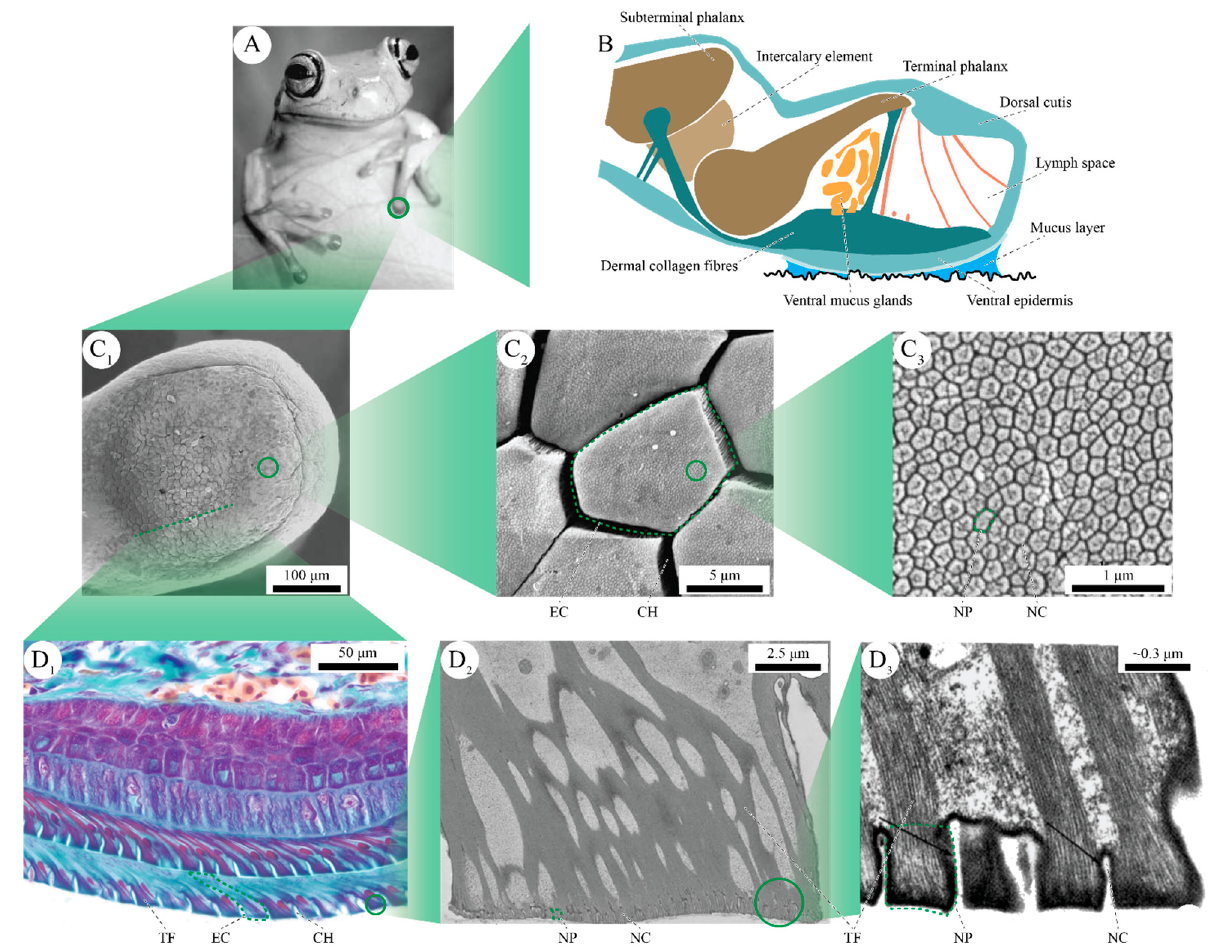
Figure 1. Functional morphology of the adhesive toe pads of healthy hylid tree frogs. ( A ) Litoria caerulea with toes in contact with a substrate. ( B ) Schematic depiction of the functionally relevant structures in the tip of a tree frog digit, lateral view. ( C 1–3 ) Superficial morphology of the ventral pad epidermis of L. caerulea , scanning electron micrographs in ventral view. (C 1 ) Toe pad. (C 2 ) Polygonal epidermal cell surrounded by channels. (C 3 ) Nanopillars. ( D 1–3 ) Internal morphology of the ventral pad epidermis shown for Hyla cinerea (D 1,3 ) and L. caerulea (D 2 ), lateral view, left—proximal, right—distal. (D 1 ) Section through the ventral epidermis stained with Crossmon’s light green trichrome including Mayer’s haematoxylin and Alcian blue. (D 2 ) Apical freestanding part of an epidermal cell. (D 3 ) Nanopillars with tonofilaments. CH, channel between epidermal cells; EC, epidermal cell; NC, channel between nanopillars; NP, nanopillars; TF, tonofilaments. A and C 1-3 modified after [34]; B and D 1 modified after [33]; D 2 modified after [35]; D 3 modified after [31]. All figures were reproduced with permission.